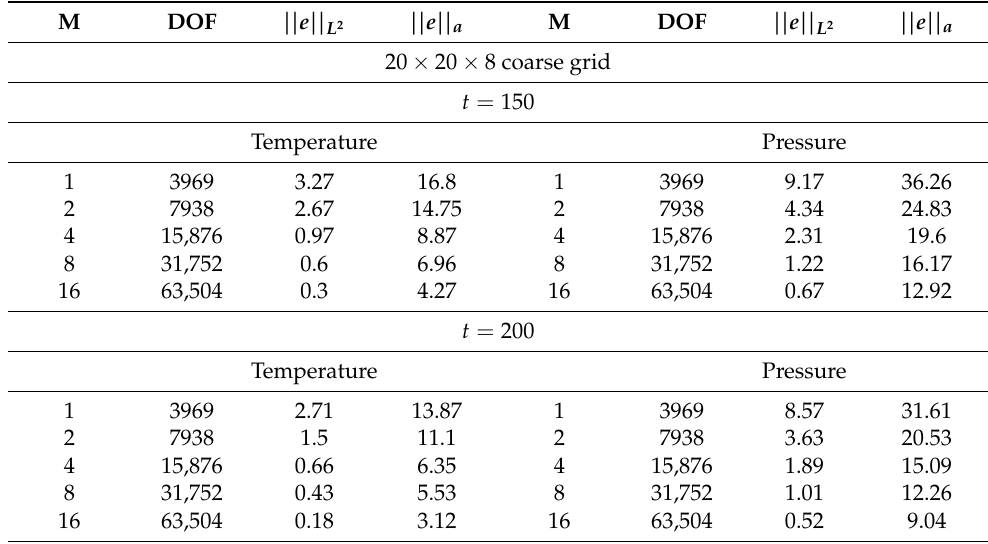
Table 3. Relative L 2 and energy errors (%) for different number of multiscale basis functions. ( DOF f = 522,774).